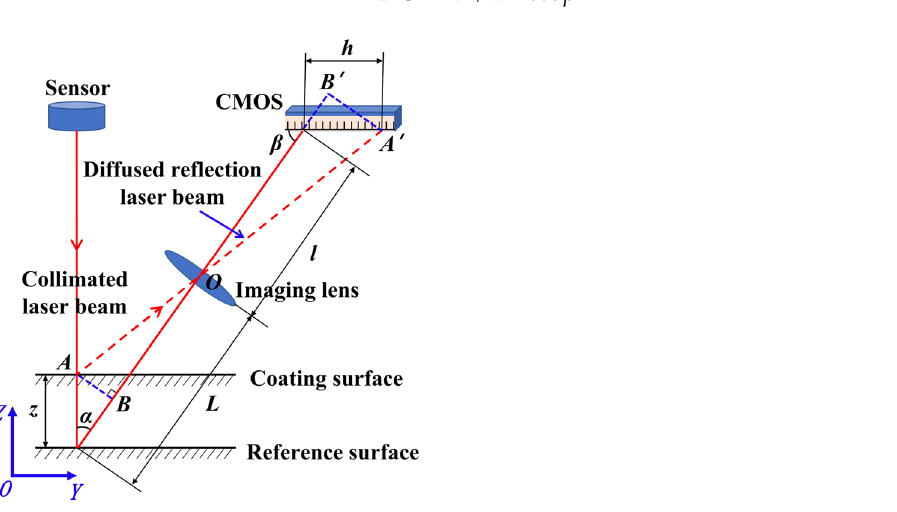
Figure 5. Schematic diagram of the principle of laser triangulation.